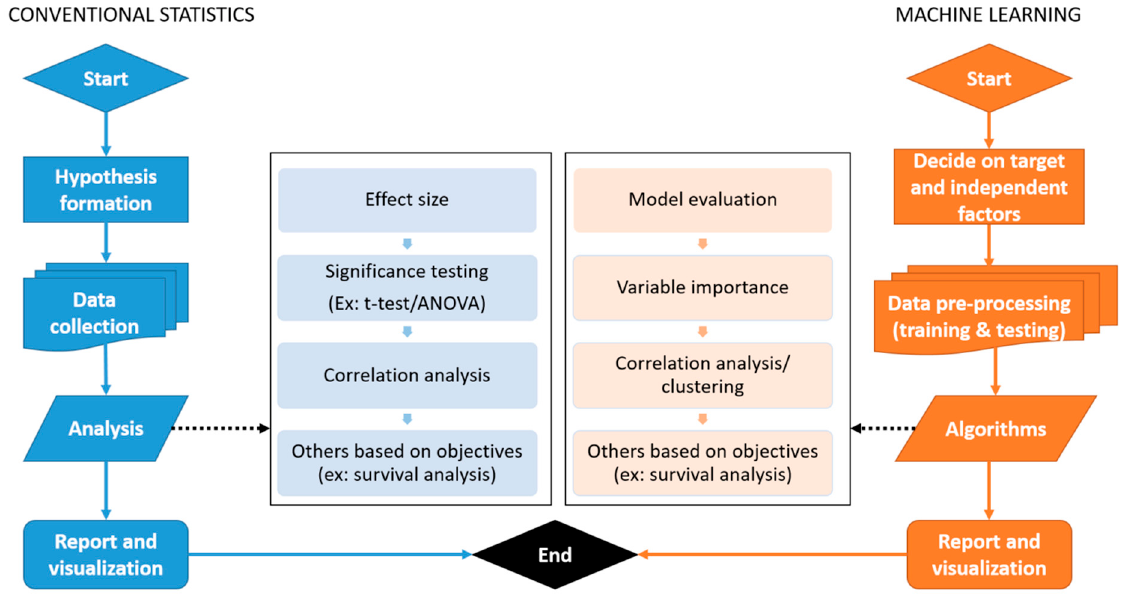
Figure 6. General workflow of conventional statistics and machine learning.